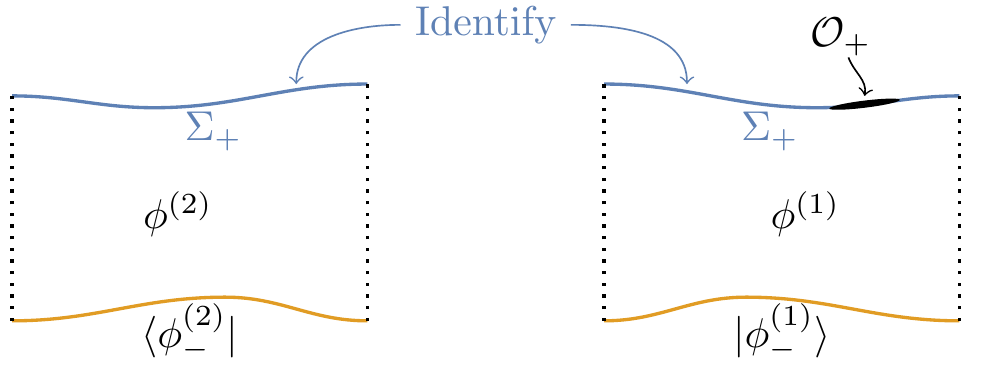
|O + | φ (1) i . The right copy of Figure 3. A path integral that computes the matrix elements h φ (2) − − the spacetime contains fields φ (1) and is weighted by e iI [ φ (1) ] , while the left copy contains fields φ (2) and is weighted by e − iI [ φ (2) ] (or more generally by the CPT conjugate of the action on the left copy). This conjugation is associated with the fact that the initial conditions for the right copy (fixing the field on Σ − ) are defined by the ket-state | φ (1) i while those for the left copy are defined − by the bra-state h φ (2) | −